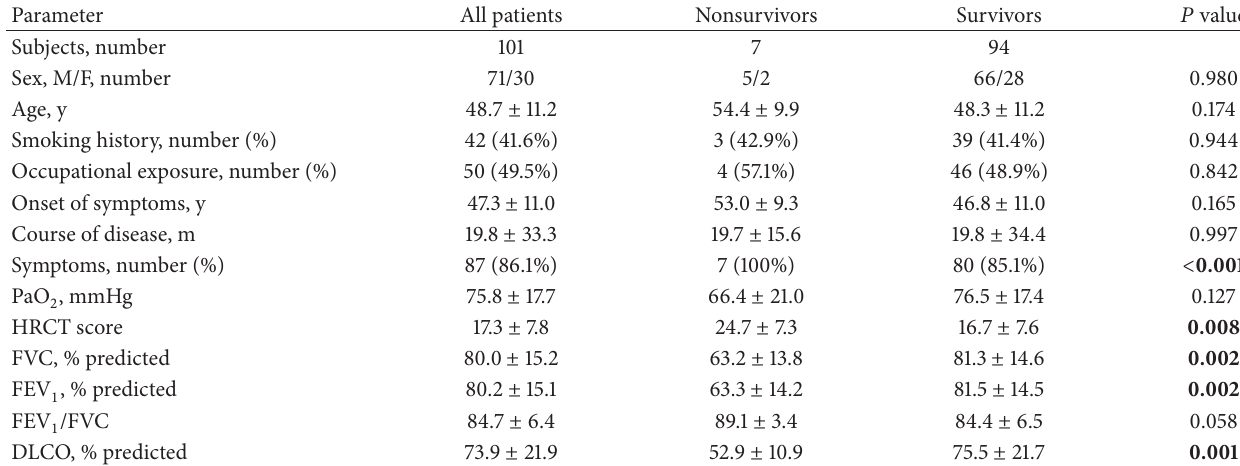
Table 5: The characteristics of the groups of survivors and nonsurvivors.